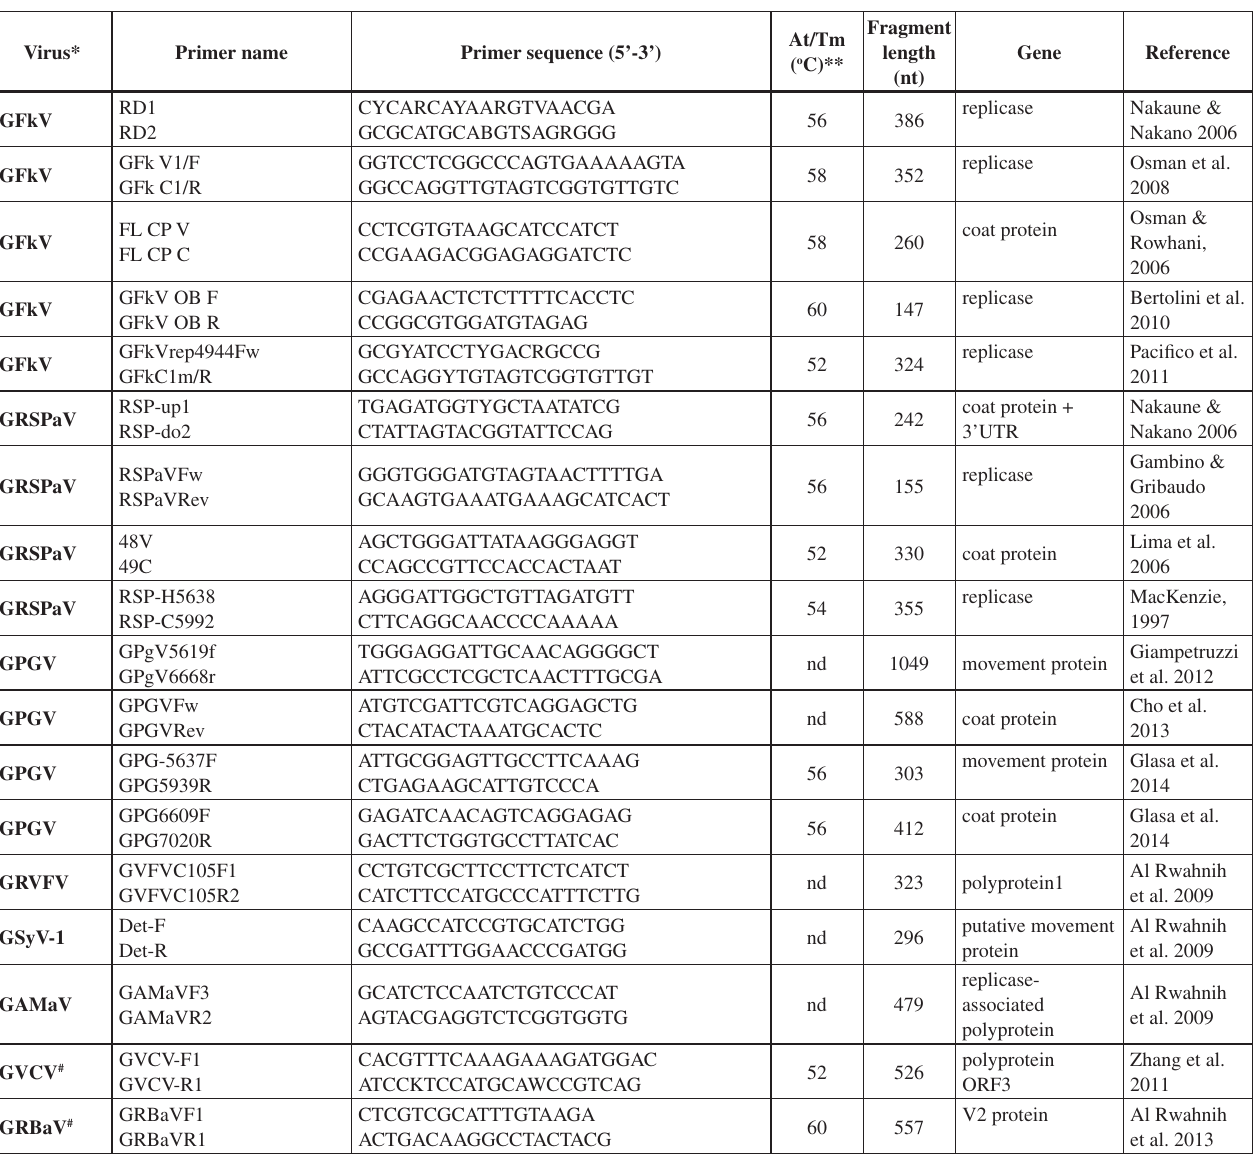
*ArMV: Arabis mosaic virus, GAMaV: Grapevine asteroid mosaic-associated virus, GBLV: Grapevine Bulgarian latent virus, GCMV: Grapevine chrome mosaic virus, GFLV: Grapevine fanleaf virus, GFkV: Grapevine fleck virus, GLRaV-1, -2, -3, -4, -5, -7 and -9: Grapevine leafroll-associated virus-1, -2, -3, -4, -5, -7 and -9, respectively, GPGV: Grapevine pinot gris virus, GRBaV: Grapevine red blotch-associated virus, GRSPaV: Grapevine rupestris stem pitting-associated virus, GRVFV Grapevine rupestris vein-feathering virus, GSyV-1: Grapevine Syrah virus-1, GVCV: Grapevine vein clearing virus, GVA: Grapevine virus A, GVB: Grapevine virus B, GVD: Grapevine virus D, GVE: Grapevine virus E, Nepo A: Nepovirus subgroup A, Nepo B: Nepovirus subgroup B, TBRV: Tomato black ring virus, ToRSV: Tomato ringspot virus